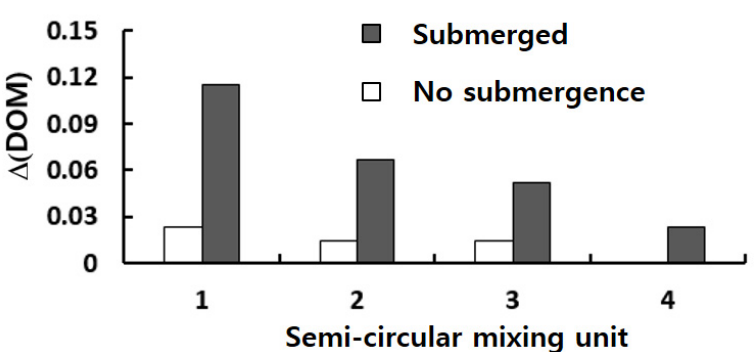
Figure 12. Comparison of the DOM increment in each semi-circular mixing unit for Re = 10.